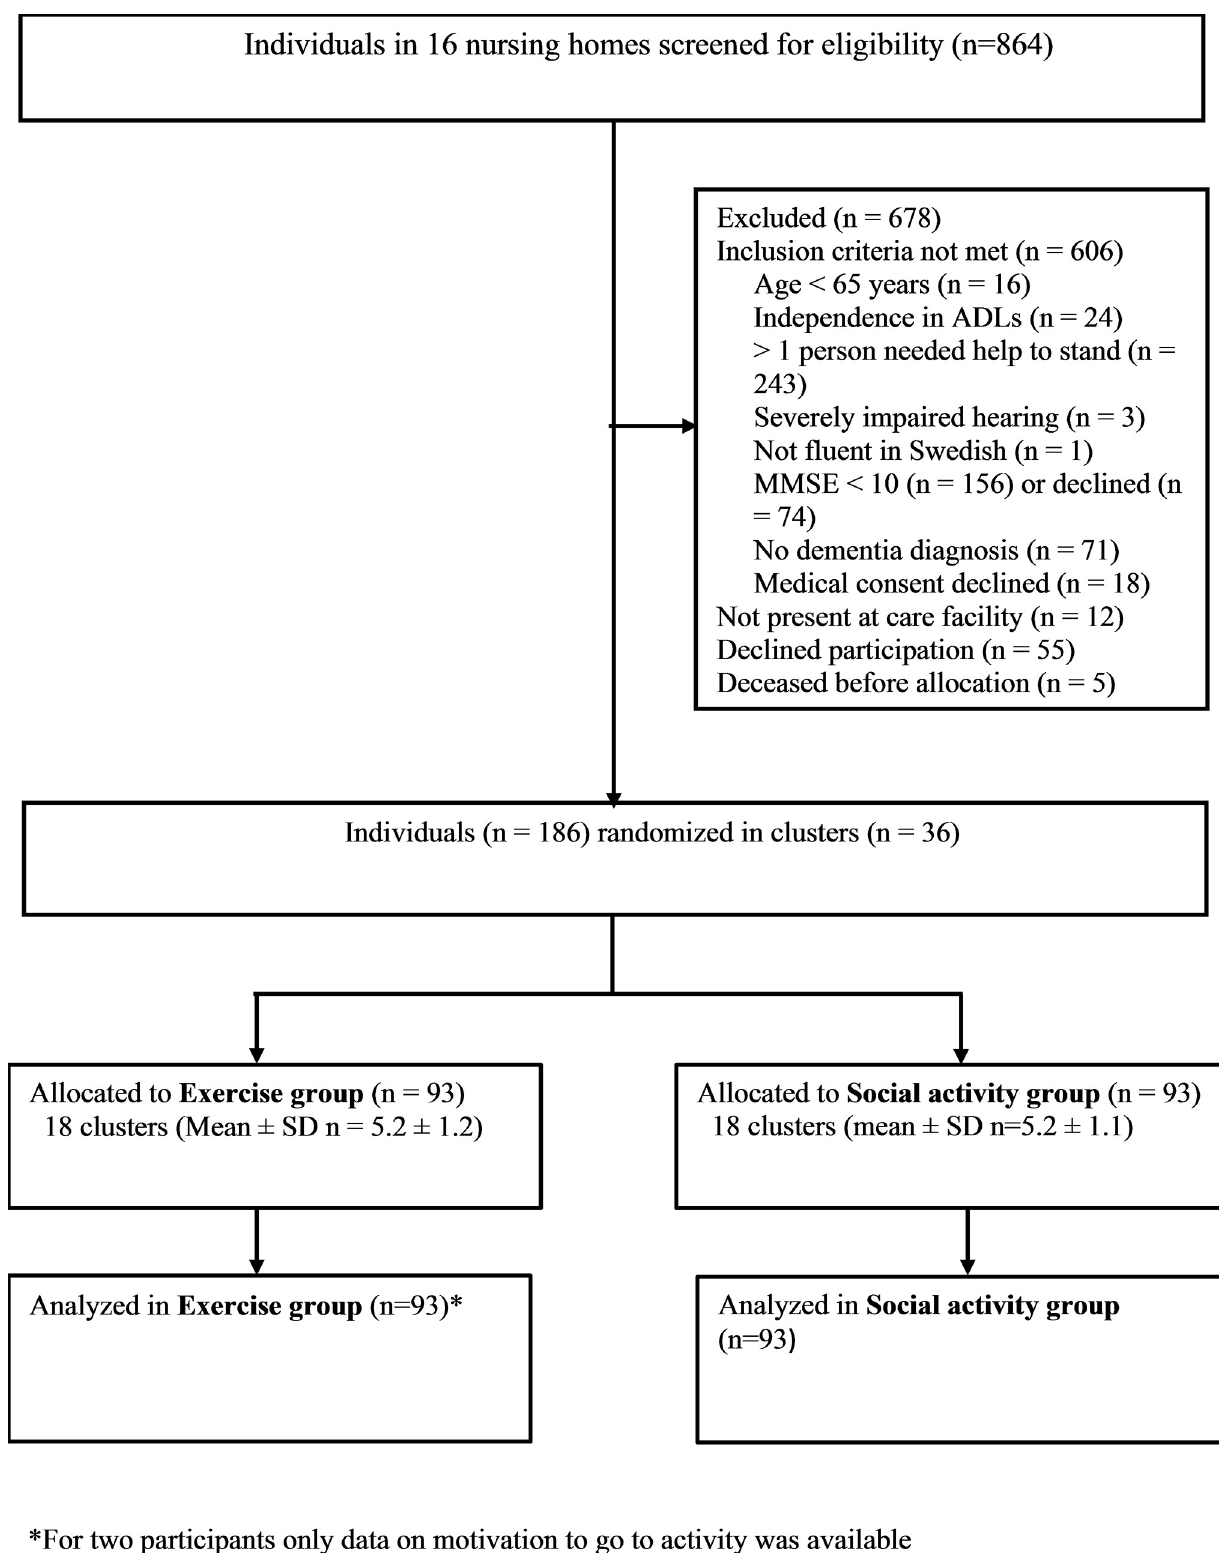
Fig 1. Flowchart of study participation. https://doi.org/10.1371/journal.pone.0206899.g001 PLOS ONE | https://doi.org/10.1371/journal.pone.0206899 November14,